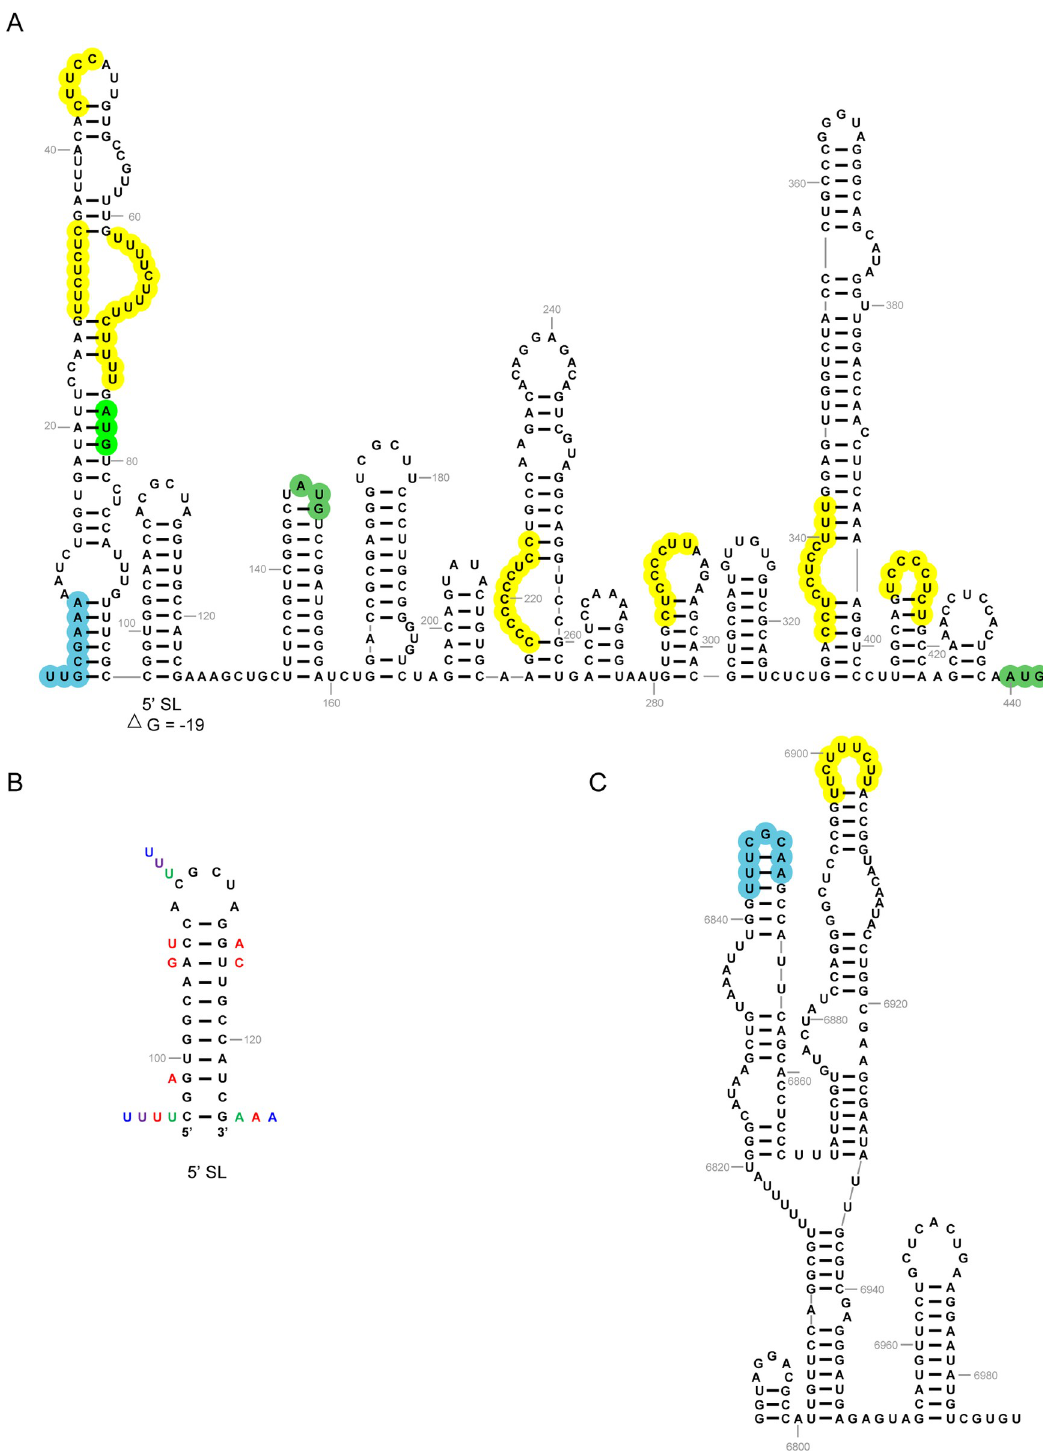
Fig 9. Predicted secondary structures of the 5’ region of ToRSV-Rasp1 RNA2 and of region 3a-b of the 3’ UTR. (A) Predicted secondary structure of the 5’ region (first 443 nts up to the third AUG codon) of ToRSV-Rasp1 RNA2. The three AUG codons are shown in green. The predicted 5’ SL located 17 nts downstream of the first AUG is shown along with the predicted free energy. A putative base pairing (sequence complementarity) with a sequence from region 3a-b of the 3’ UTR shown in panel C is also indicated with the light blue highlight (B) Close-up of the 5’ SL structure. Sequence variation occurring in ToRSV isolates are